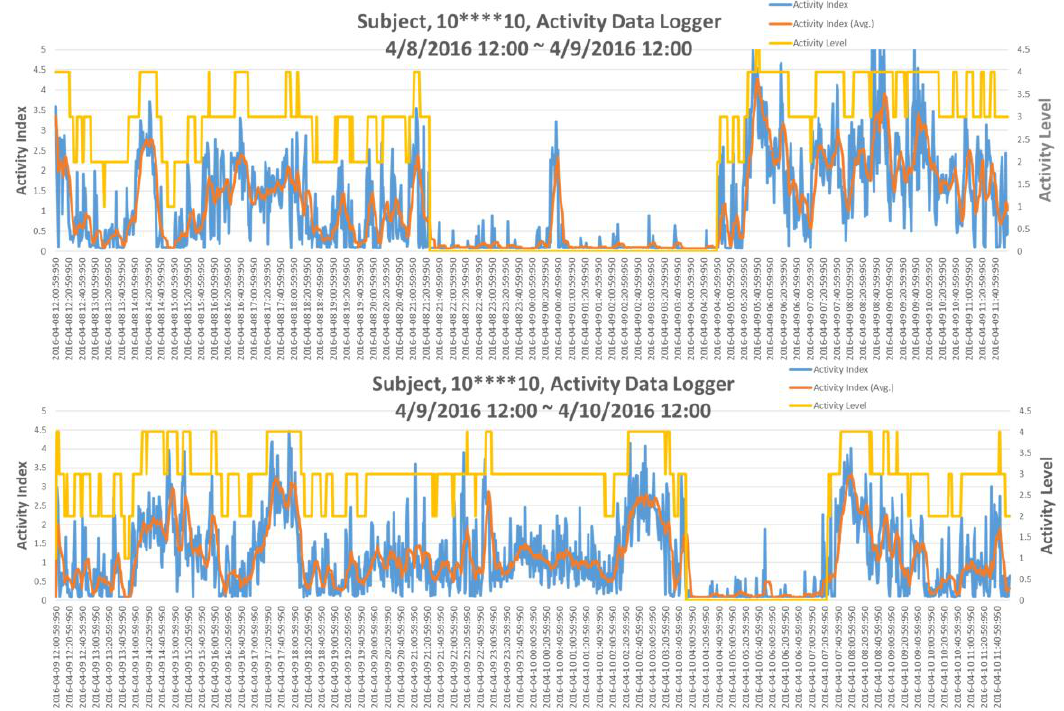
Figure 5. The AI pattern plots of a single subject over two consecutive days.